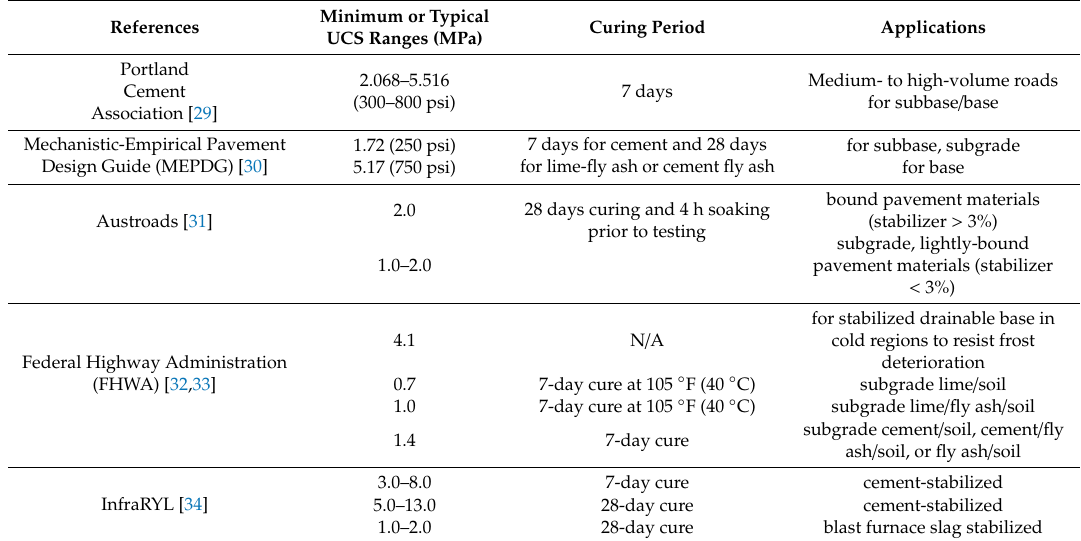
Table 1. Unconfined compressive strength requirements for base / subbase / subgrade of